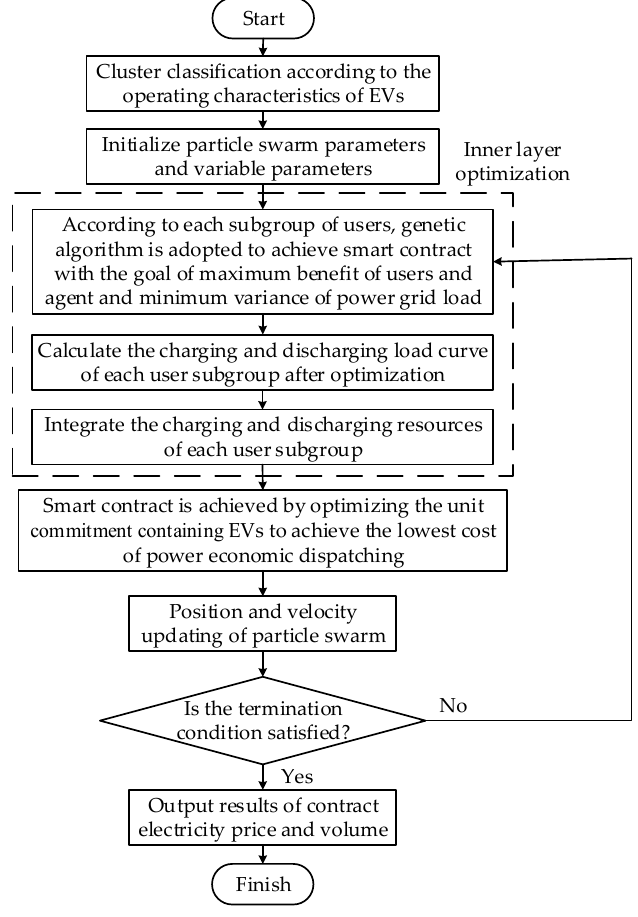
Figure 2. Solution flow of smart contract models.